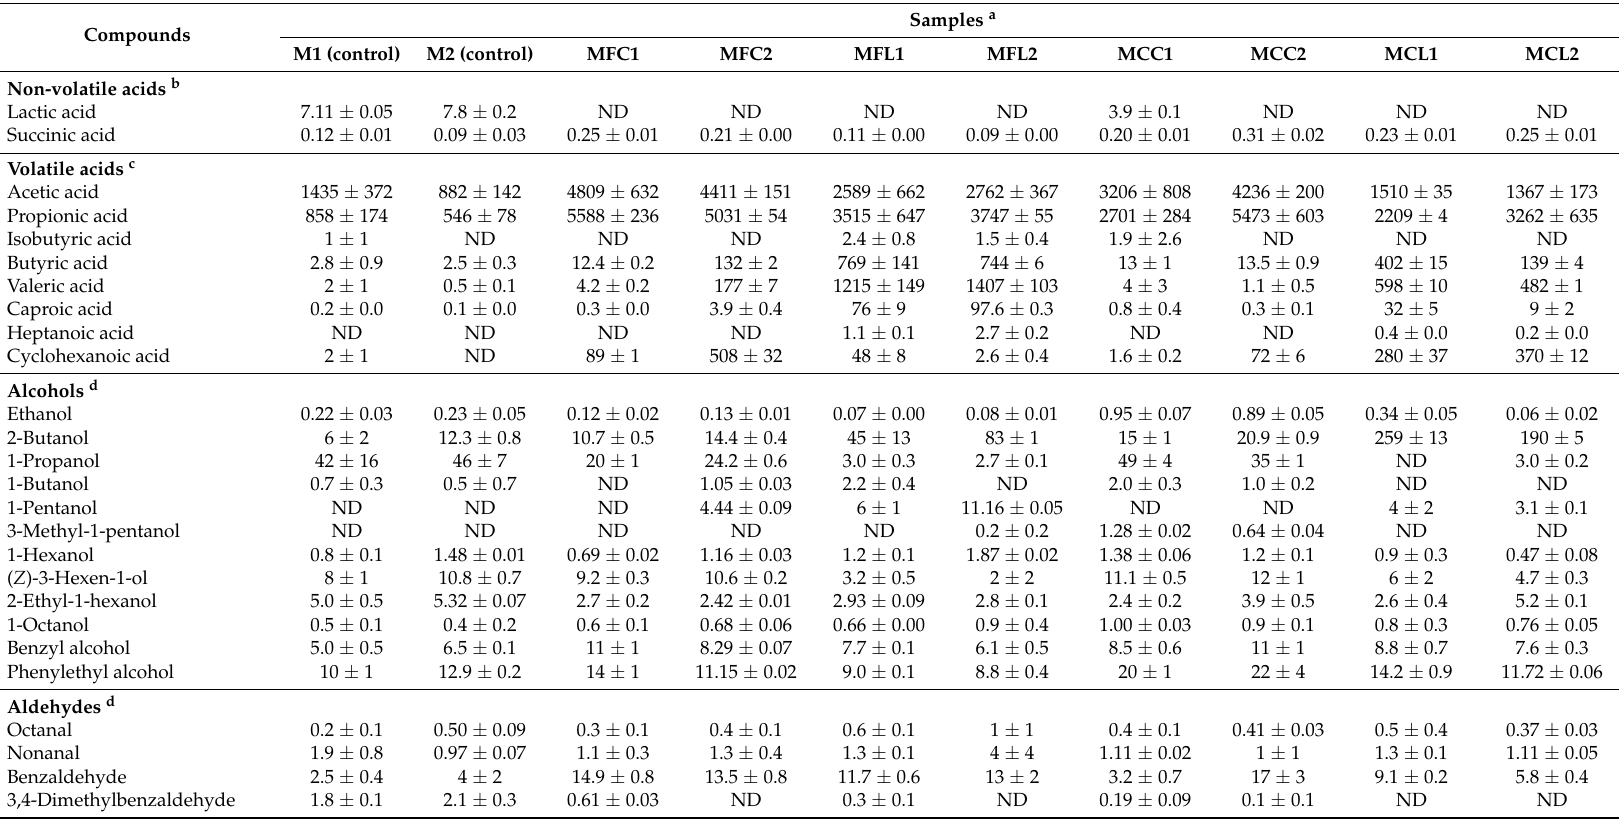
Table 3. The concentration of metabolites in spoiled and unspoiled (control) brine samples from the Manzanilla